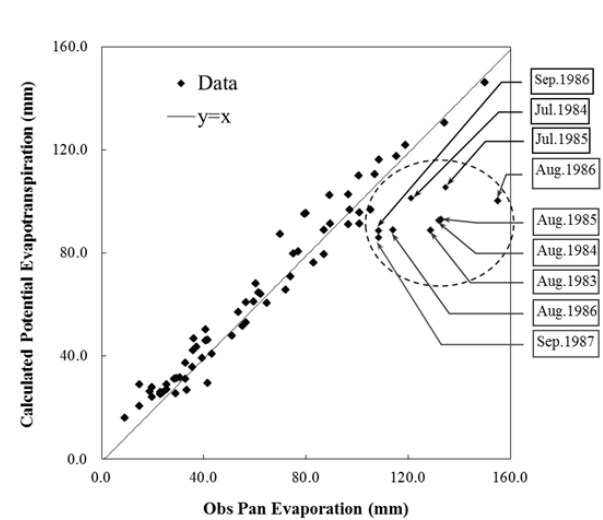
Figure 3. Comparison of the calculated results and observed evap-